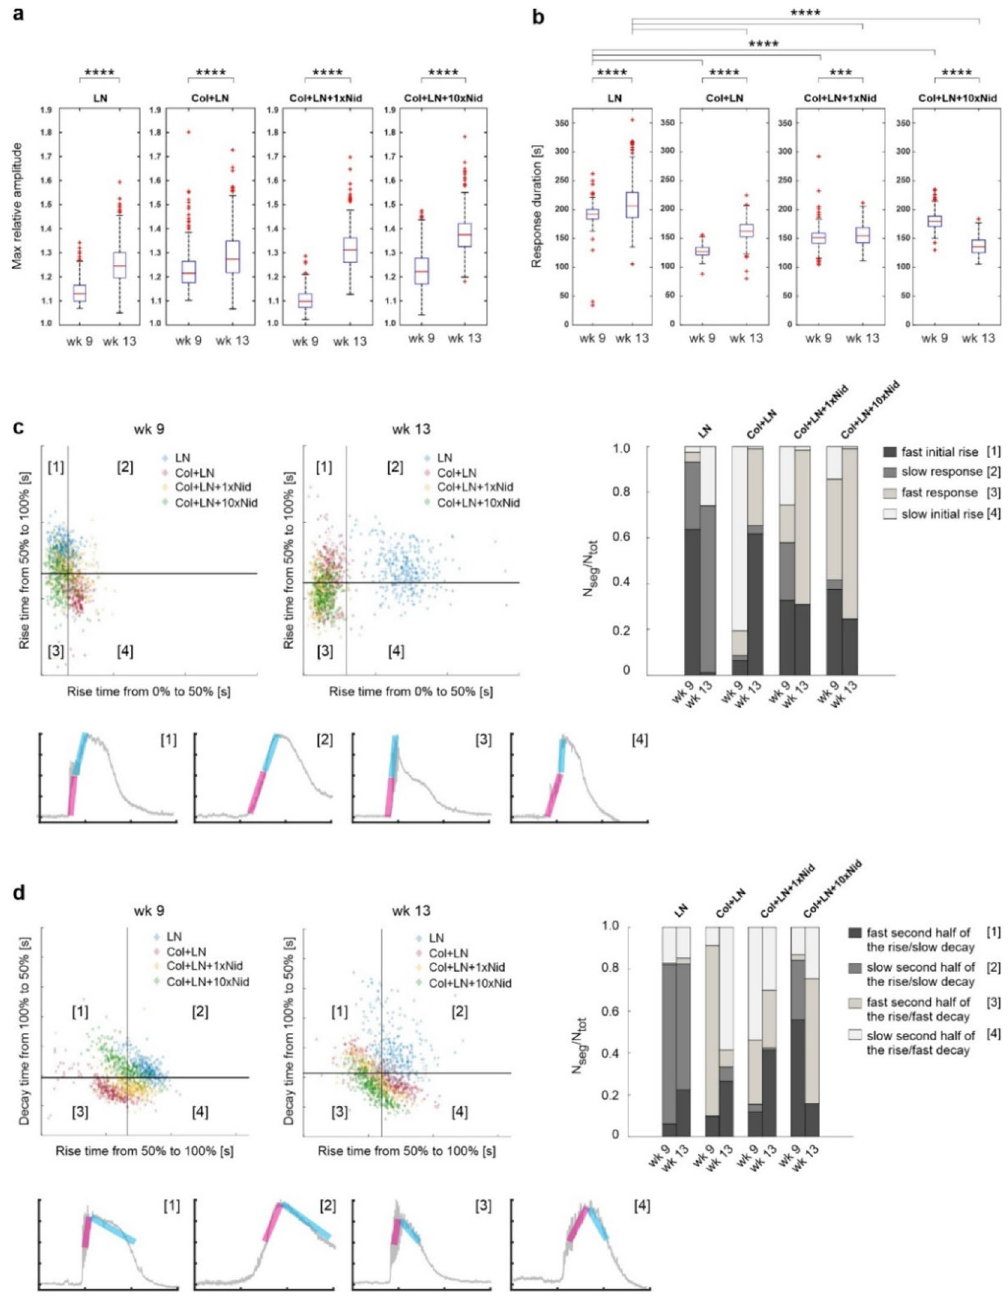
Figure 5. Visualization of the Ca 2+ response parameters. Boxplots of maximum relative amplitude ( a ) and response duration at 50% intensity ( b ) at weeks 9 and 13. The red line represents the median value and the box extends to 25th and 75th percentiles. The red crosses mark values considered as outliers, outside approximately 99% of the population. ( c ) Upper left: Scatter graph between the first half (horizontal axis) and the second half (vertical axis) of the response rise time at weeks 9 (left) and 13 (right). The scatter fields are divided into four segments by taking the average value of each axis (black lines). Upper right: The number of responses in each segment per total number of responses is represented as a stacked bar graph for each culture surface coating at weeks 9 and 13 (right). Lower left: Examples of responses characterizing each segment. The response segment for the horizontal axis parameter is highlighted with a magenta bar and for the vertical axis parameter with a cyan bar. ( d ) Similar scatter and stacked bar graphs with example responses as in (c) for the second half of the response rise time (horizontal axis) and the intensity decay time from maximum to 50% intensity (vertical axis). ***p < 0.001, ****p < 0.0001 (Mann–Whitney U). Col—collagen IV, LN—laminin,